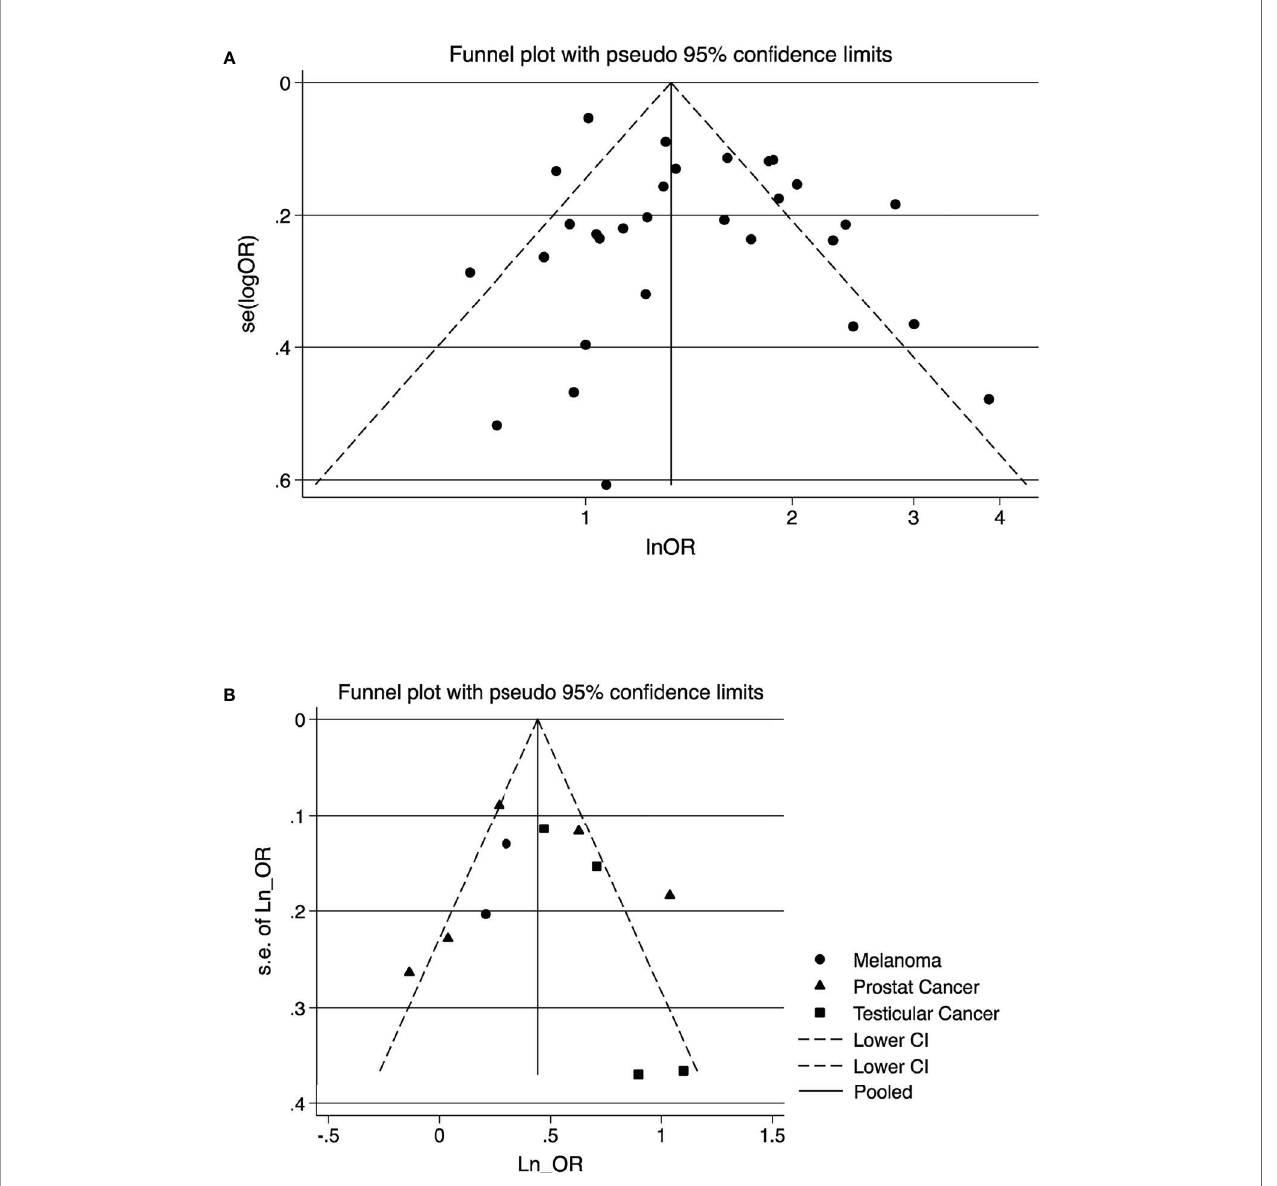
FIGURE 4 | Funnel plot for the visual assessment of publication bias of the outcome of studies; (A) composite outcome of all cancers (B) testicular cancer, melanoma, and prostate cancer. (A) Composite outcome of cancers. (B) Testicular cancer, melanoma, and prostate